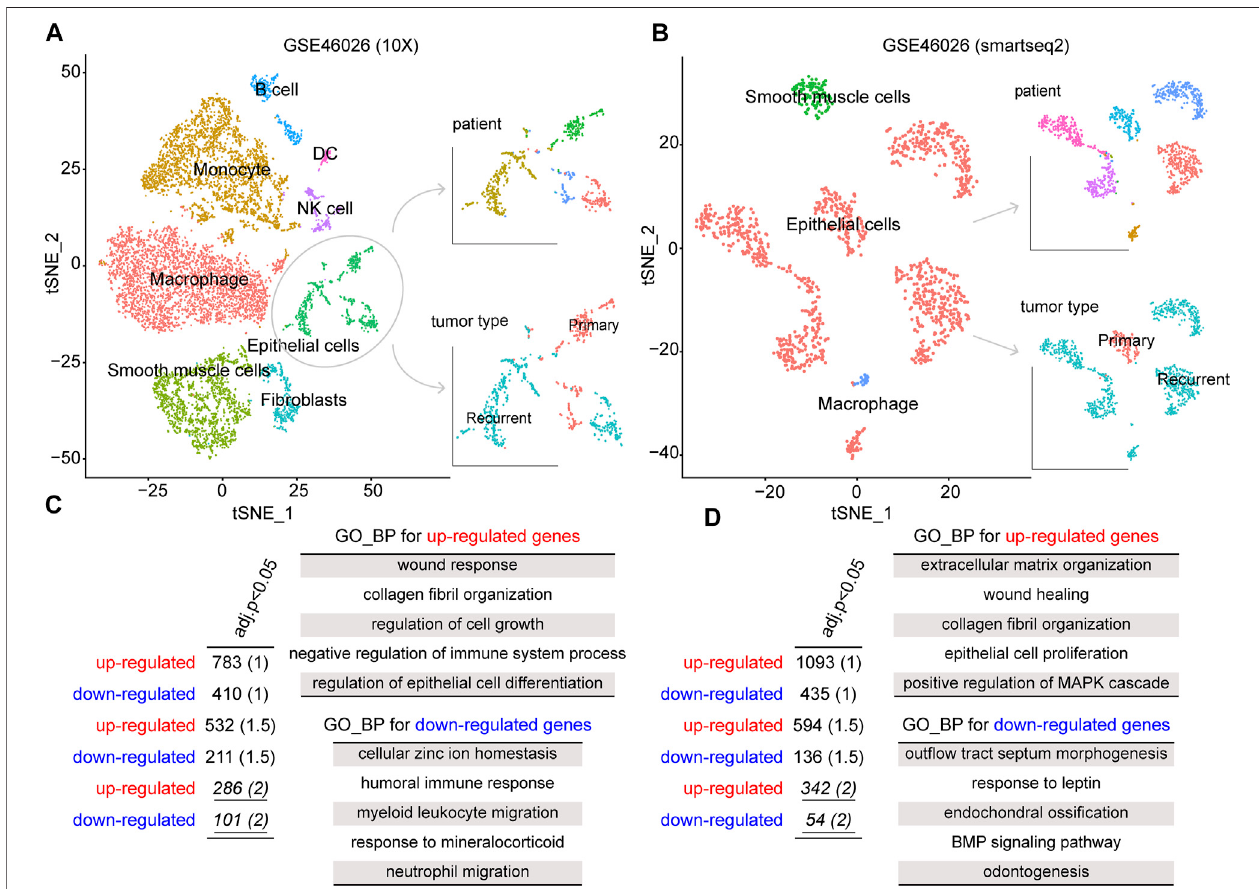
FIGURE1| tSNEplotofallcellscollectedbyGSE146026,colorbycelltype,patients,andtumortypeinthe (A) 10Xplatformand (B) smartseq2platform.Thegene ontology (GO) – biological process (BP) terms were identi fi ed from dysregulated genes for (C) 10X platform and (D) smartseq2 datasets.